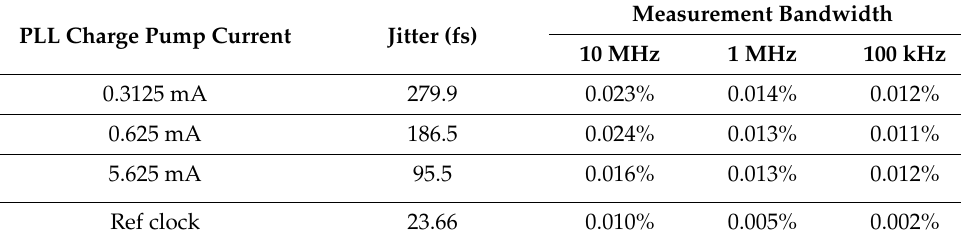
Table 4. Rms amplitude stability measured in different bandwidths for different charge-pump